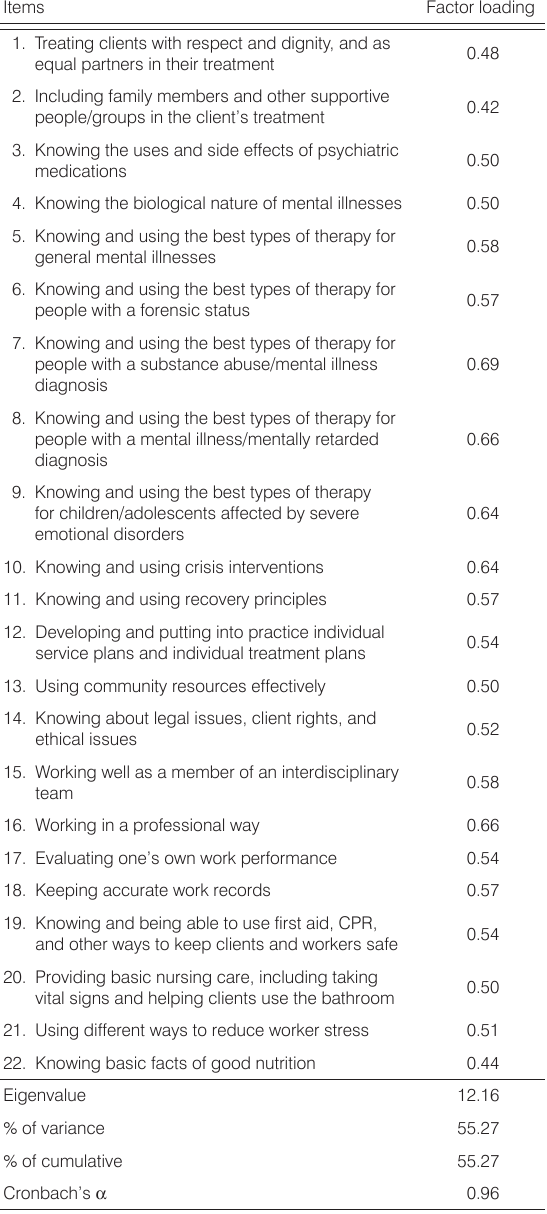
Table 1. Factor analysis of the Competency Assessment Tool-Mental Health (the section on importance of skills and